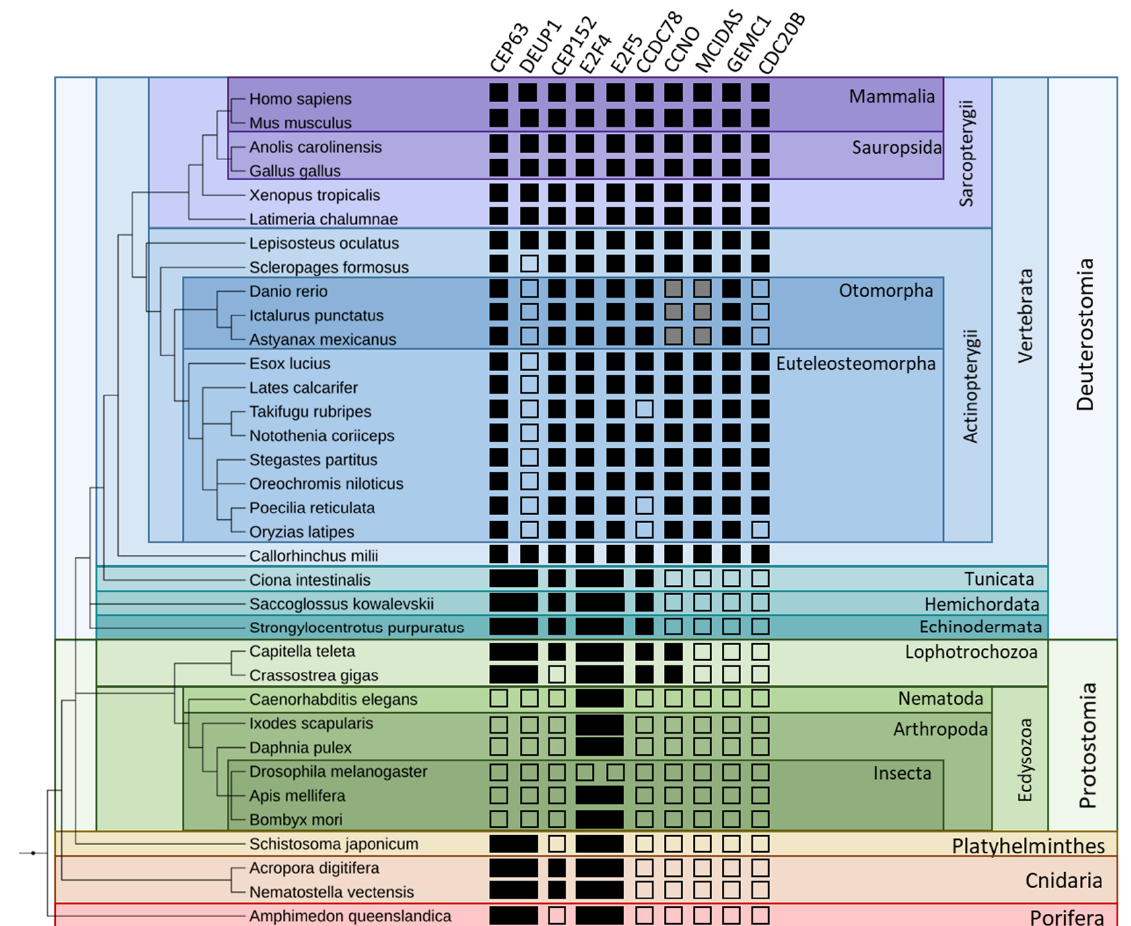
Figure 4. Phylogenetic distribution of multiciliated genes in Metazoa. Only a selected pertinent subset of the studied species is represented. A black square indicates the presence of an ortholog in the concerned species, a blank square indicates the absence of an ortholog. Black rectangles indicate the presence of an ancestral gene before its split in two paralogs. Gray squares indicate the presence of a homologue with an abormaly divergent sequence.